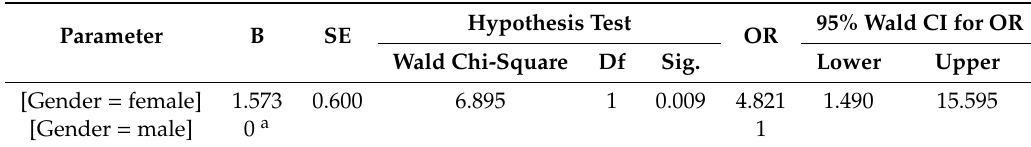
Table 1. Ordinal Logistic Regression model result predicting zookeepers’ scores on the Brambell’s Five Freedoms importance